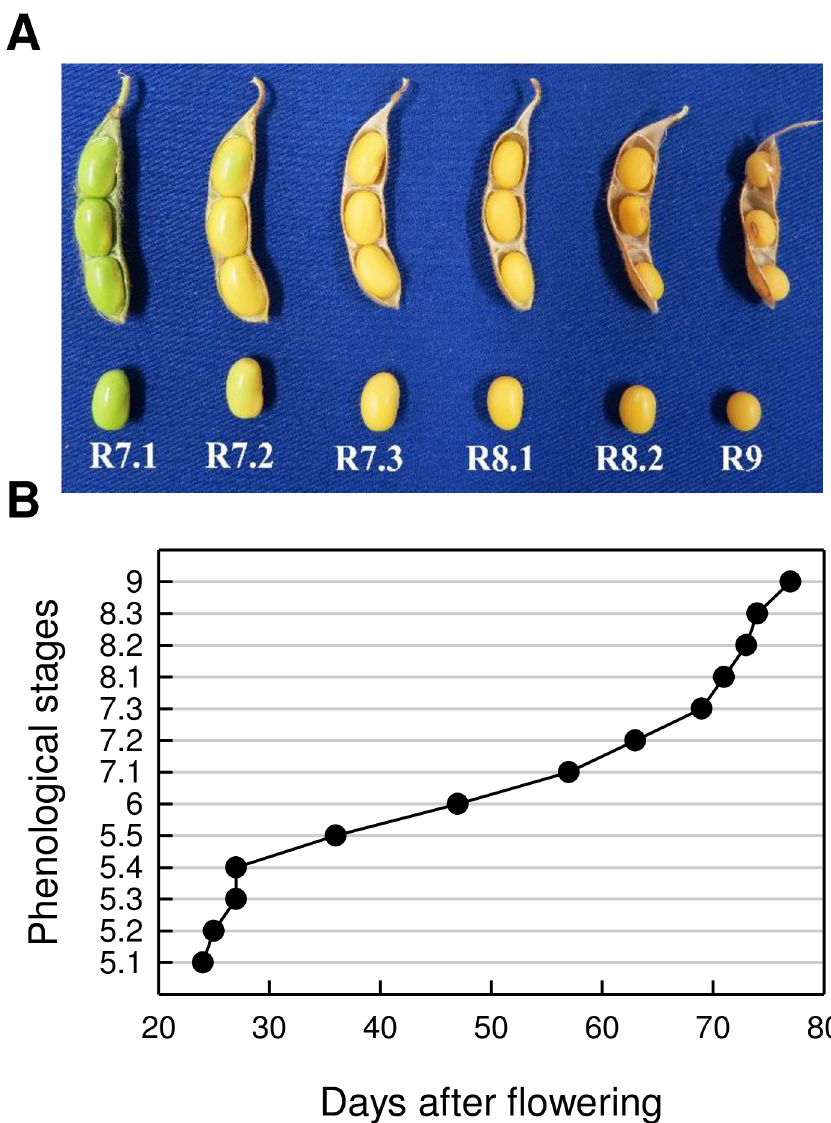
Fig 1. Seed and pod development of soybean. (A) Seed phenologicalstages duringthe acquisitionof seed longevity(2013 crop). (B) The relationship betweenseed age and phenological stages (2014 crop). Stage 9 corresponds to dry mature